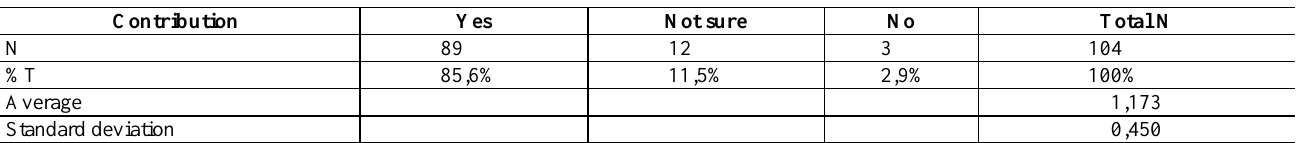
Table 2: Frequency table of future importance of operations capabilities to better compete nationally and internationally